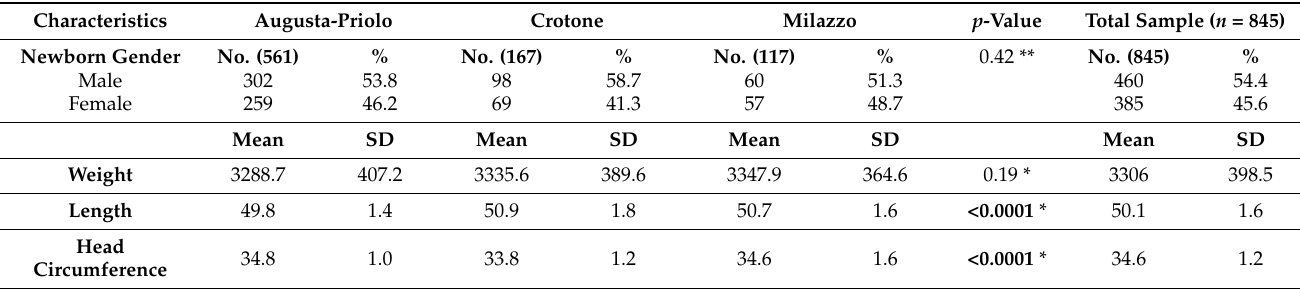
Table 3. Characteristics of the newborns in the total sample and in each NPCS: continuous variables are reported as mean ± SD, while categorical variables are reported as numbers and percentages. Significant p -values are in bold. For each categorical variable, in parentheses, the total number of responders is